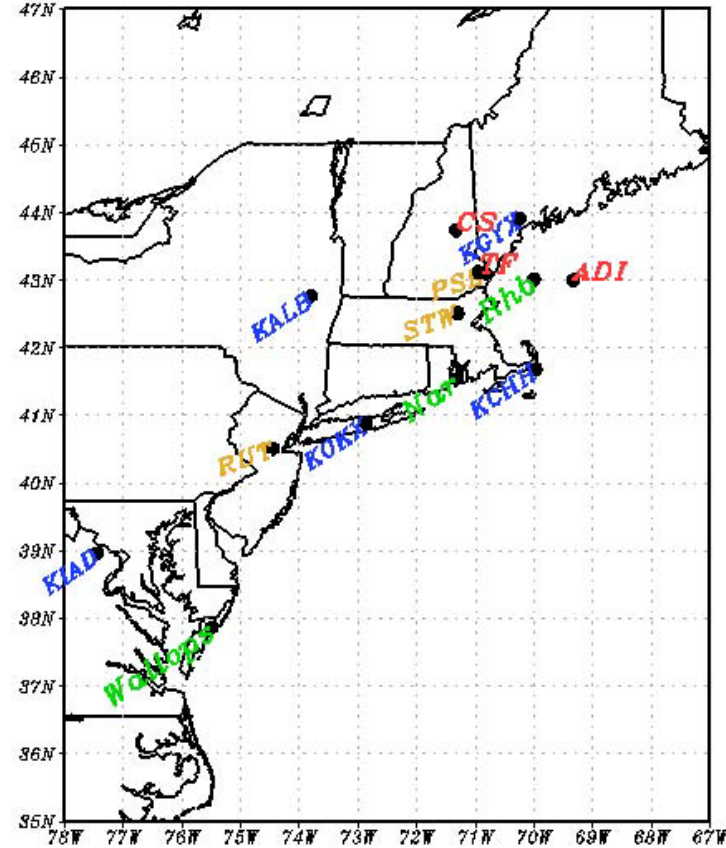
Figure 1. Observation locations. AIRMAP sites are in red; National Weather Service site are in blue; radar wind observation sites are in dark yellow; and IONS-04 sites are in